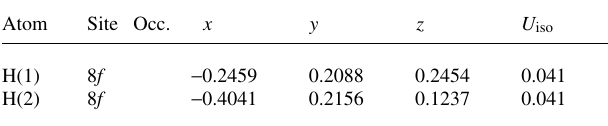
Table 2. Atomic coordinates and displacement parameters (in Å 2 )